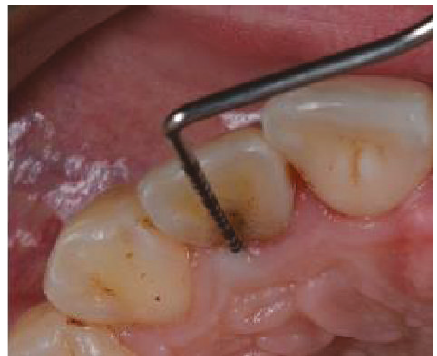
Figure 15: Clinical examination after 12 months.